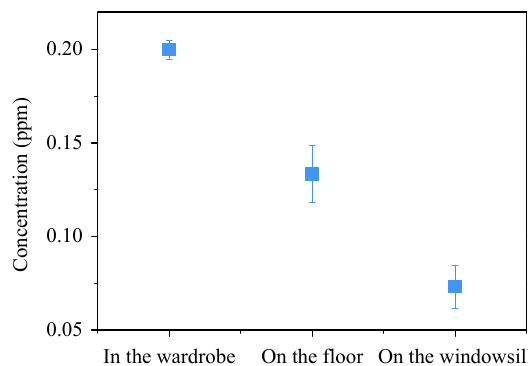
Figure 8. The formaldehyde determination results in a newly decorated house.